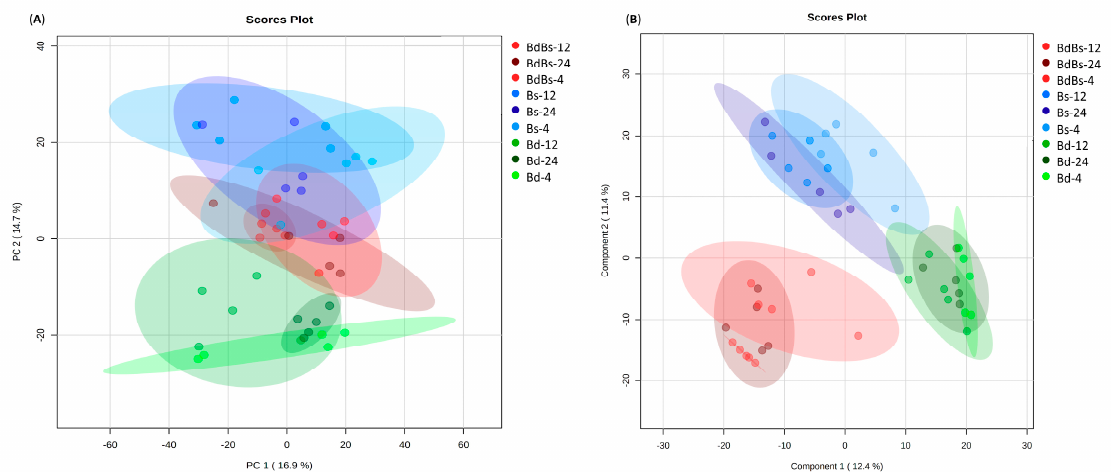
Figure 4. ( A ) PCA and ( B ) partial least squares ‐ discriminant analysis (PLS ‐ DA) of endosperm metabolites in B. distachyon Bd21 (Bd), B. stacei ABR114 (Bs), and B. hybridum ABR113 (BdBs) at 4, 12 and 24 HAI.